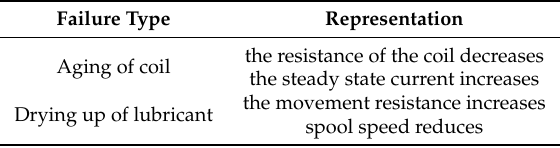
Table 1. The impact of each type of